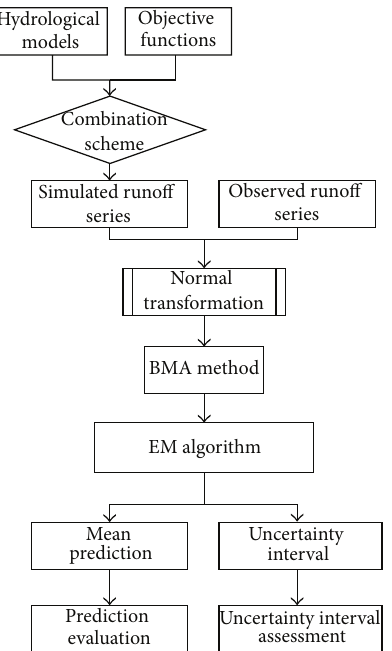
Figure 1: Flowchart of using BMA scheme for hydrological ensem- ble prediction as well as for prediction uncertainty